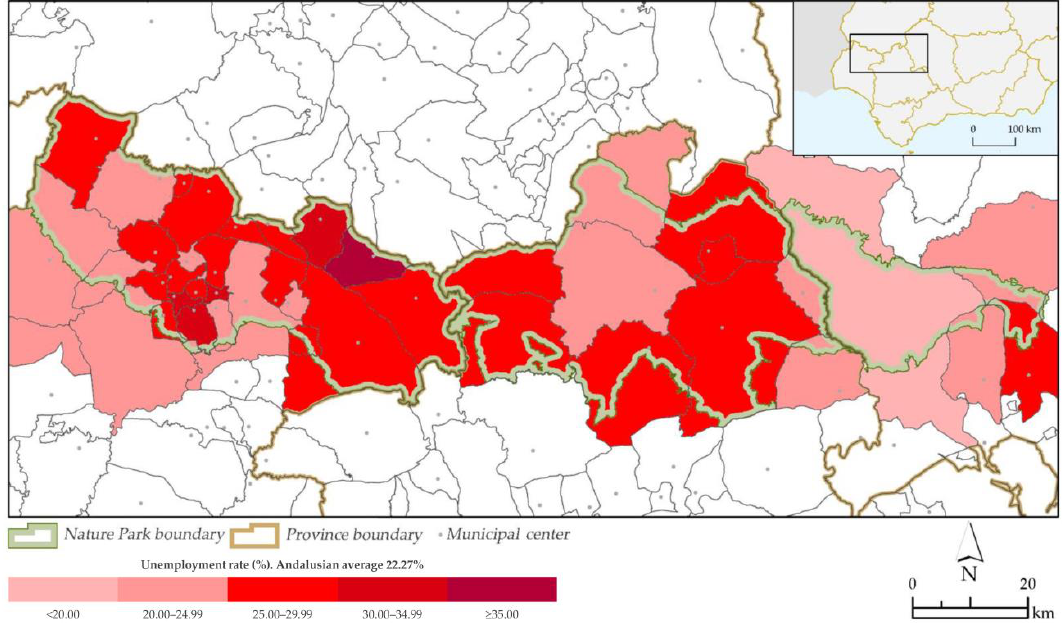
Figure 14. Unemployment rate (2019). Source: [85]; authors ’ elaboration.